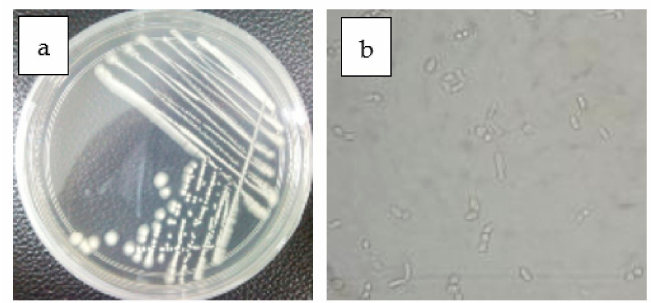
Figure 4. Morphological characterization of T. asahii ; ( a ) T. asahii on PDA plate, ( b ) T. asahii cell shape.